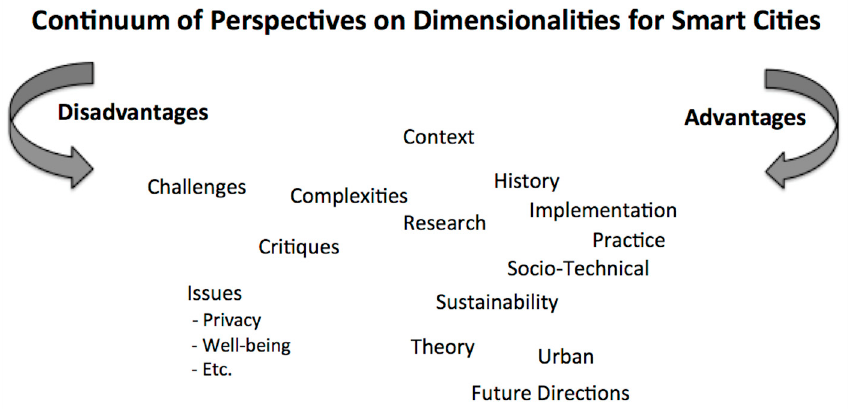
Figure 2. Advantages and disadvantages: continuum of perspectives on dimensionalities for smart cities.